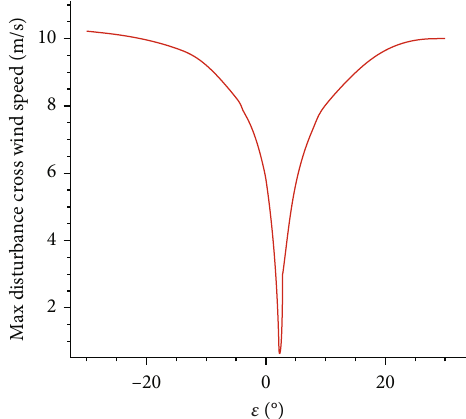
Figure 39: Max crosswind disturbance rejection performance in di ff erent rotor incline angles.